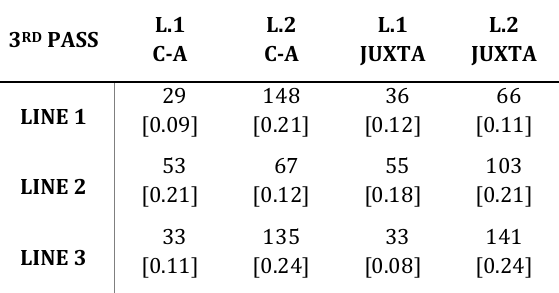
Table 4A. Third-pass dwell times (per word) follow- ing progressive saccades, Fisher Least Square Difference= 52 ms [likelihood of pro-fixations, Fisher Least Square Difference=0.07].